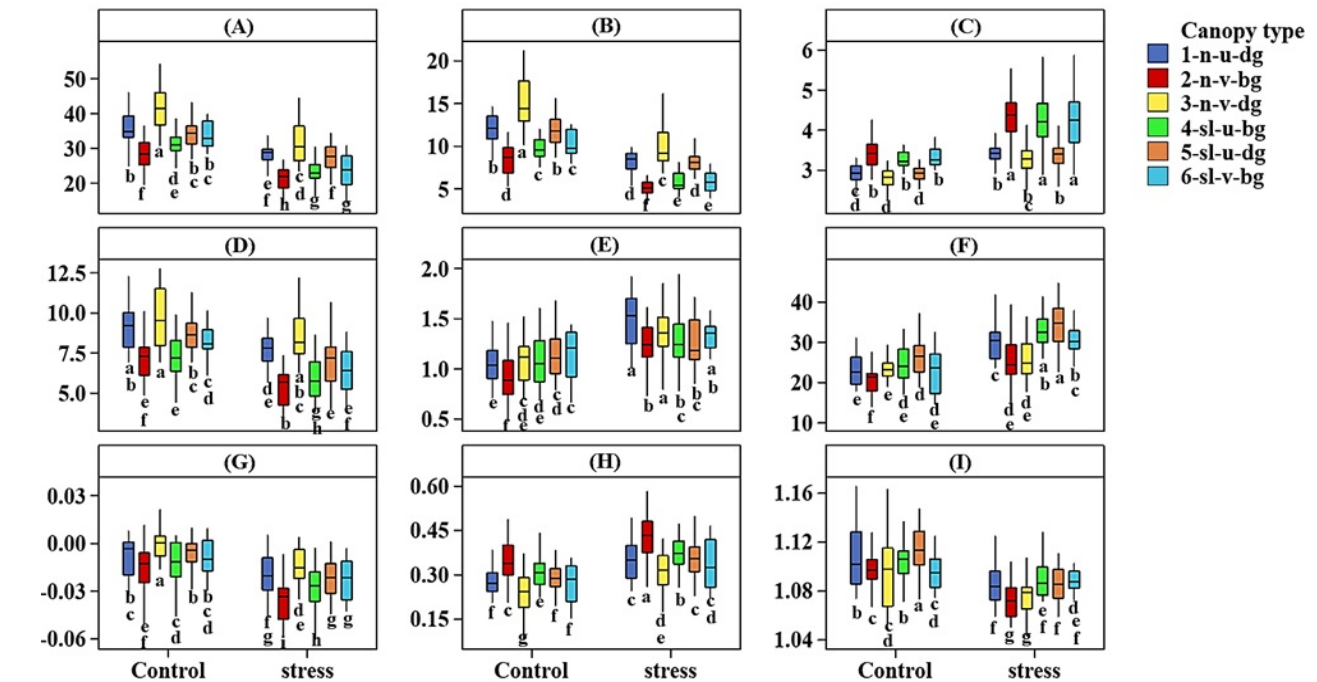
Figure 3. Box plot showing the interaction effects of heat stress and canopy type on: chlorophyll a ( A ), chlorophyll b ( B ), chlorophyll a / b ratio ( C ), carotenoid ( D ), anthocyanin ( E ), wax ( F ) concentrations (µg cm − 2 ); and vegetation indices: PRI ( G ), NPCI ( H ), and WBI ( I ) measured on pea leaf stipules under control and stress environments at Rosthern and Saskatoon, Canada, 2014–16. The size of box represents 50% of the middle data, the line in the middle of the box is the median, and the whiskers represent the range of the data. Boxes labeled with same letters within trait are not significantly different at p < 0.05. N = 24 for type 1, 40 for type 2, 24 for type 3, 32 for type 4, 48 for type 5, and 16 for type 6. The control conditions are 2014 late seeding date at Rosthern and 2016 normal seeding date at Saskatoon; and the stress conditions are 2015 late seeding date at Rosthern and Saskatoon, Canada.; Canopy type legend: n, sl, u, v, bg, and dg represents normal leaf, semi-leafless; upright habit, vining habit, bright-green color, and dark-green color, respectively; and vegetation indices: PRI, photochemical reflectance index; NPCI, normalized pigment chlorophyll ratio index; WBI, water band index.